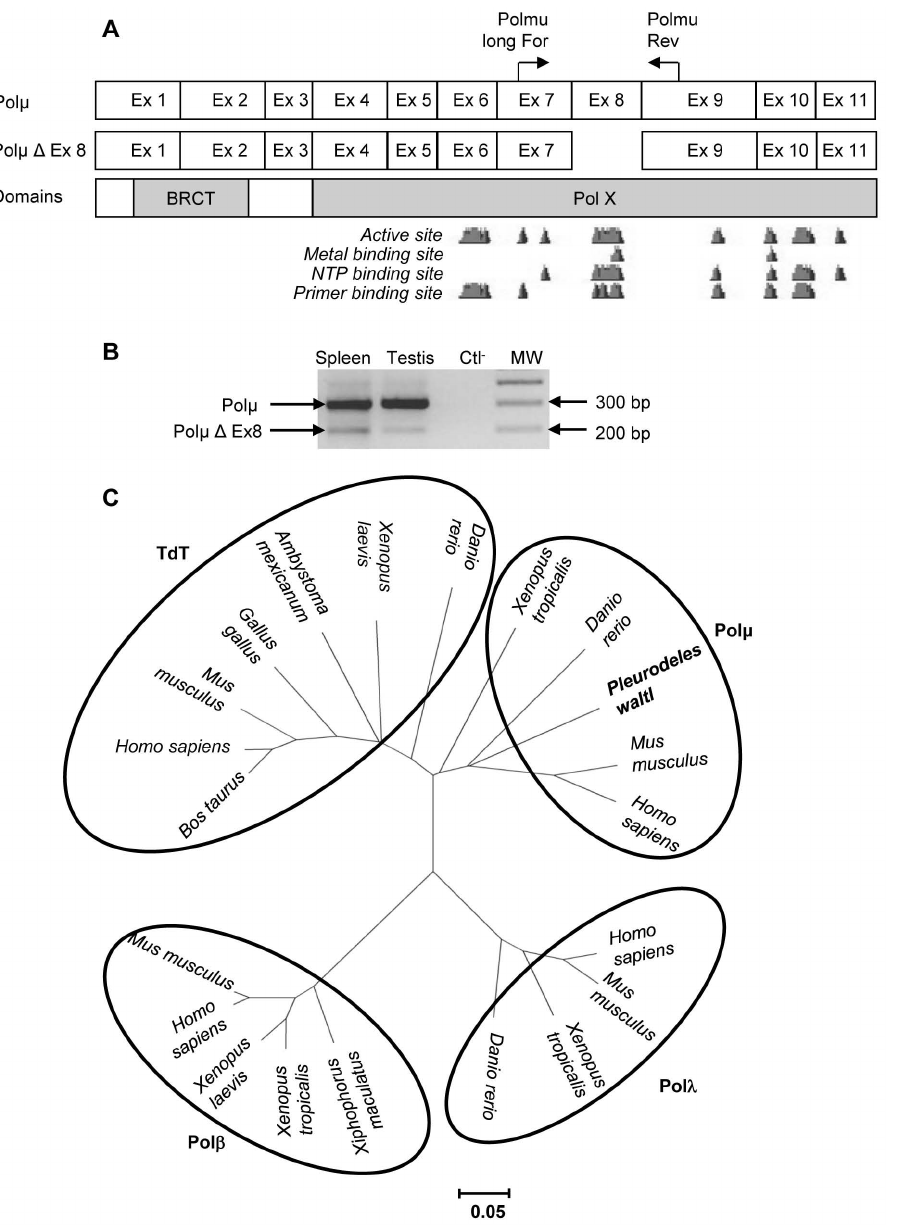
Figure 1. Pleurodeleswaltl DNA polymerase m . Schematic representation of P. waltl Pol m mRNAs ( A ). The short variant (Pol m D Ex 8) presents a 103 bp deletion corresponding to exon 8. This deletion removes one part of the active site of the protein. The BRCT (breast cancer suppressor protein carboxy-terminal) and the Pol X domain, which contains the active site, are required for Pol m function. Pol m variants were amplified using primers indicated by horizontal arrows ( B ). Quantification of the obtained PCR products using a Gel Doc 2000 and the Quantity One v.4.3.1 software (Bio-Rad, Hercules, CA, USA) indicates that the short isoform represents 16% and 6% of the Pol m transcripts in the spleen and testis of P. waltl , respectively. Ctl 2 =negative control. MW=100 bp DNA ladder. A cladogram was then constructed by neighbor joining ( C ) supported with 1000 bootstrap replications using the MEGA4 software (http://www.megasoftware.net/) and the following sequences: Terminal deoxynucleotidyl transferase (TdT); Bos taurus (DAA14763), Homo sapiens (BAB72001), Mus musculus (NP_001036693), Gallus gallus (NP_990720), Ambystoma mexicanum (AA092254), Xenopus laevis (NP_001079251), Danio rerio (AAS89780). Polymerase beta; Mus musculus (NP_035260), Homo sapiens (NP_002681), Xenopus laevis (NP_001081643), Xenopus tropicalis (AAH74537), Xiphophorus maculatus (AAU11319). Polymerase lambda; Danio rerio (NP_998408), Xenopus tropicalis (NP_001093716), Mus musculus (NP_064416), Homo sapiens (NP_001167555). Polymerase mu; Homo sapiens (NP_037416), Mus musculus (NP_059097), Danio rerio (NP_956542), Xenopus tropicalis (NP_001164987), Pleurodeles waltl (HE583591). The scale bar corresponds to the evolutionary